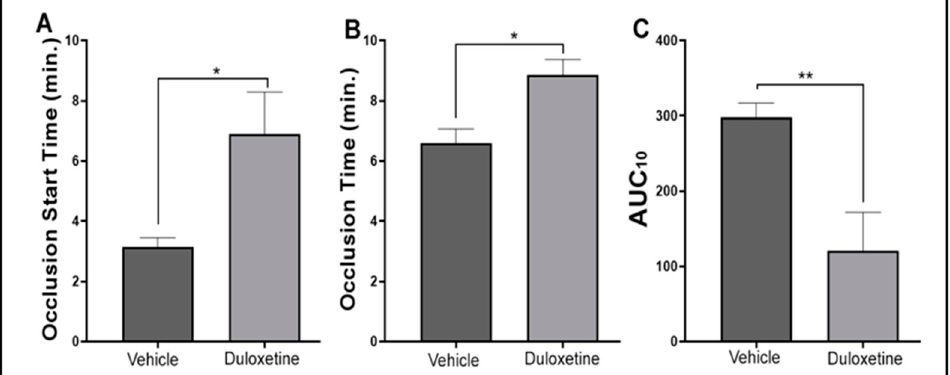
Figure 7. Duloxetine modulates hemostasis in human platelets. Blood was collected from healthy human subjects, treated with 50 µ M duloxetine or the vehicle for one minute before being subjected to T-TAS01 system analysis (PL chip flow under arterial shear stress conditions on a collagen coated surface). The occlusion start time ( A ), occlusion time ( B ) and area under the curve/AUC 10 ( C ) were then measured. These data were obtained from six different healthy human subjects. Data were compared by running the student t -test using GraphPad Prism (* p < 0.05; *** p < 0.01).